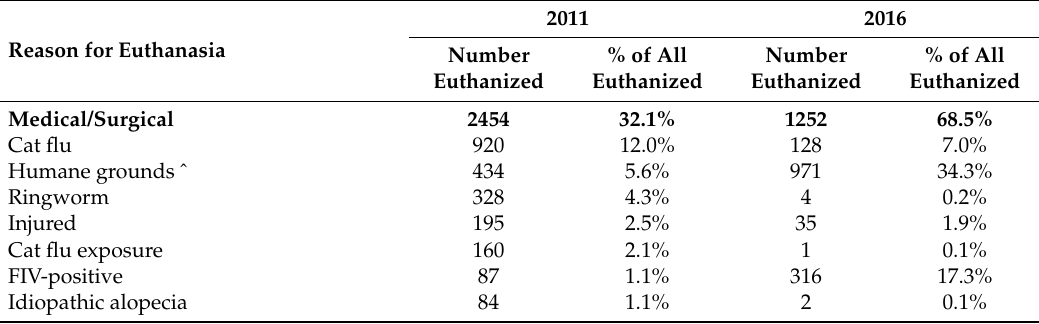
Table 6. Summary of the medical and surgical reasons that cats were euthanized at RSPCA Queensland shelters for the years 2011 and 2016 for admissions in which the cat was euthanized by day 90 after admission; ( b ) summary of the age and behavioral reasons for which cats were euthanized at RSPCA Queensland shelters for the years 2011 and 2016 for admissions in which the cat was euthanized by day 90 after